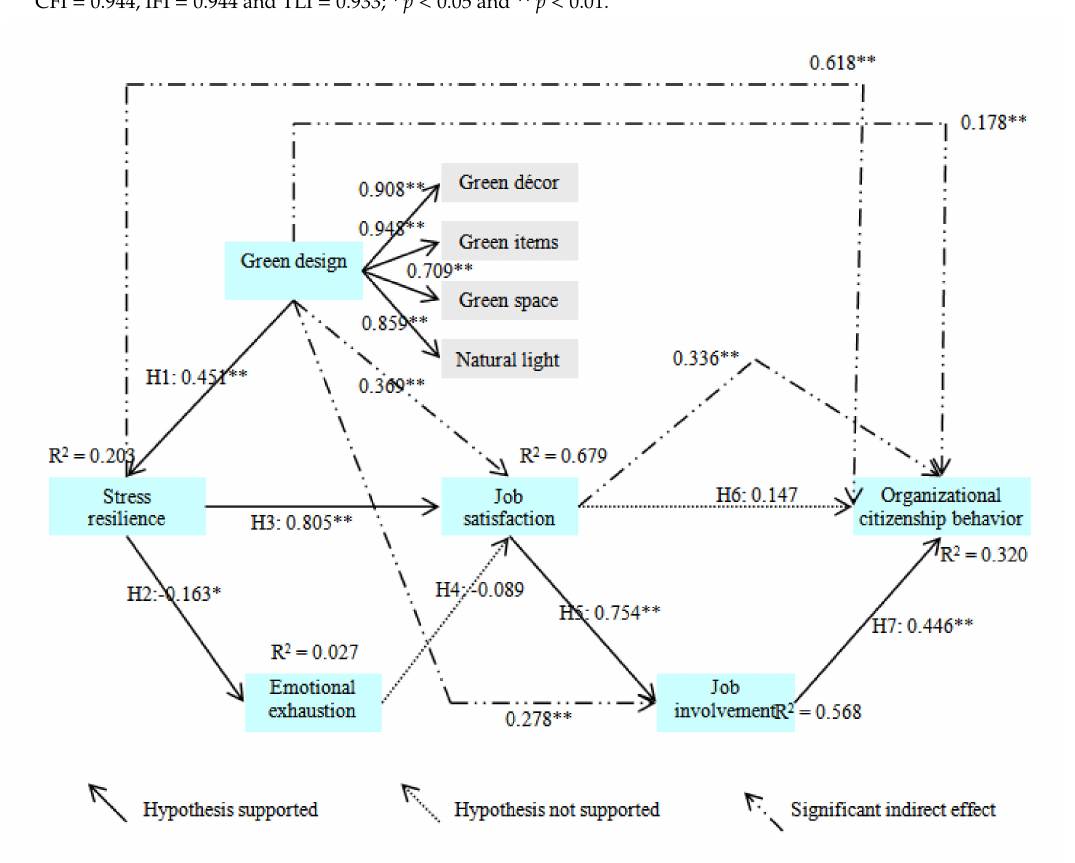
Figure 2. Results of the structural model and the baseline model assessment ( n =